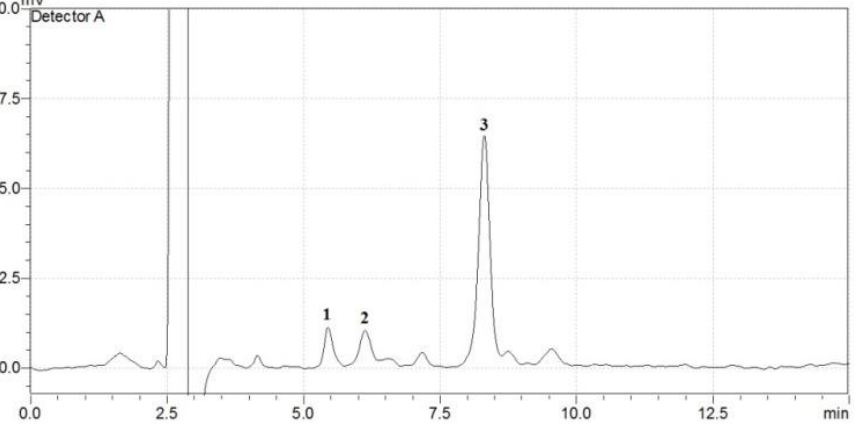
Figure 1. Representative chromatographic fingerprint of soluble carbohydrates having sucrose as